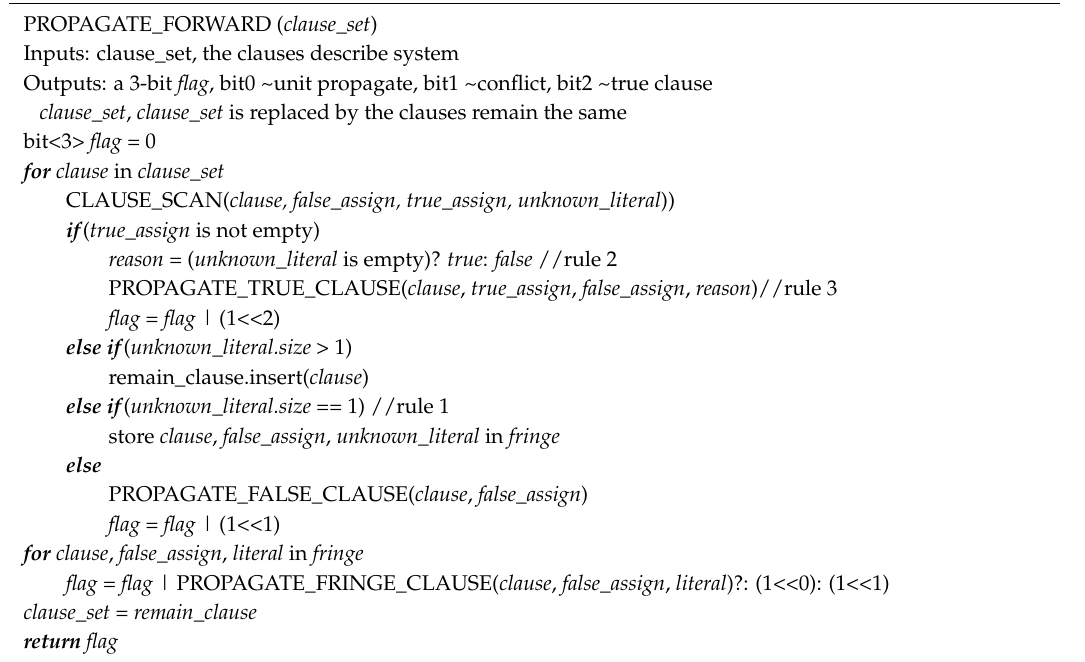
Algorithm 2. Pseudocode of PROPAGATE_FORWARD for